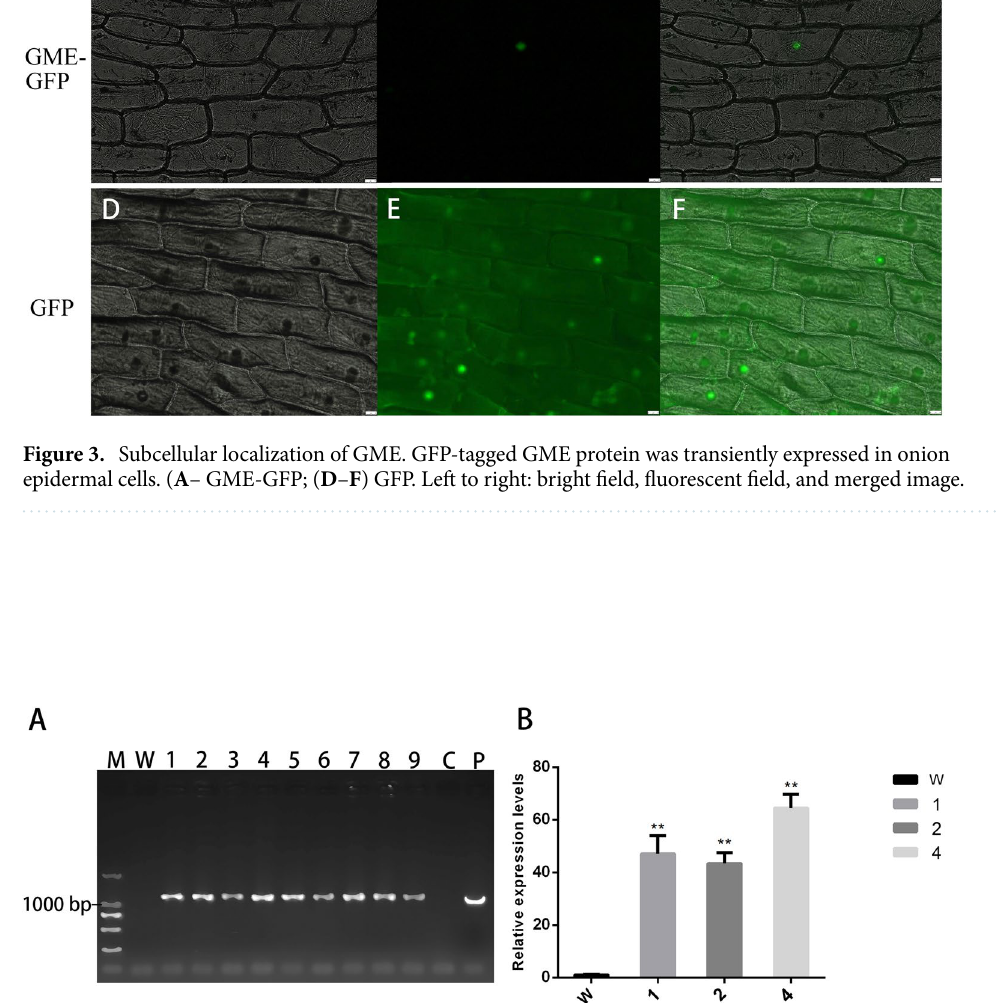
Figure 4. Transgenic tobacco identification using ( A ) genomic PCR, M: DL2000 marker, W: wild-type tobacco, 1–9: transgenic tobacco lines, C: blank control, P: positive control. ( B ) CvGME expression in wild- type and transgenic tobacco line 1, 2 and 4, W: wild-type tobacco; 1, 2 and 4: T1 generation of three different transgenic lines. Data showed as mean ± SD of three independent experiments. Asterisks indicate values that are significantly different from those of the wild-type plants ( p <